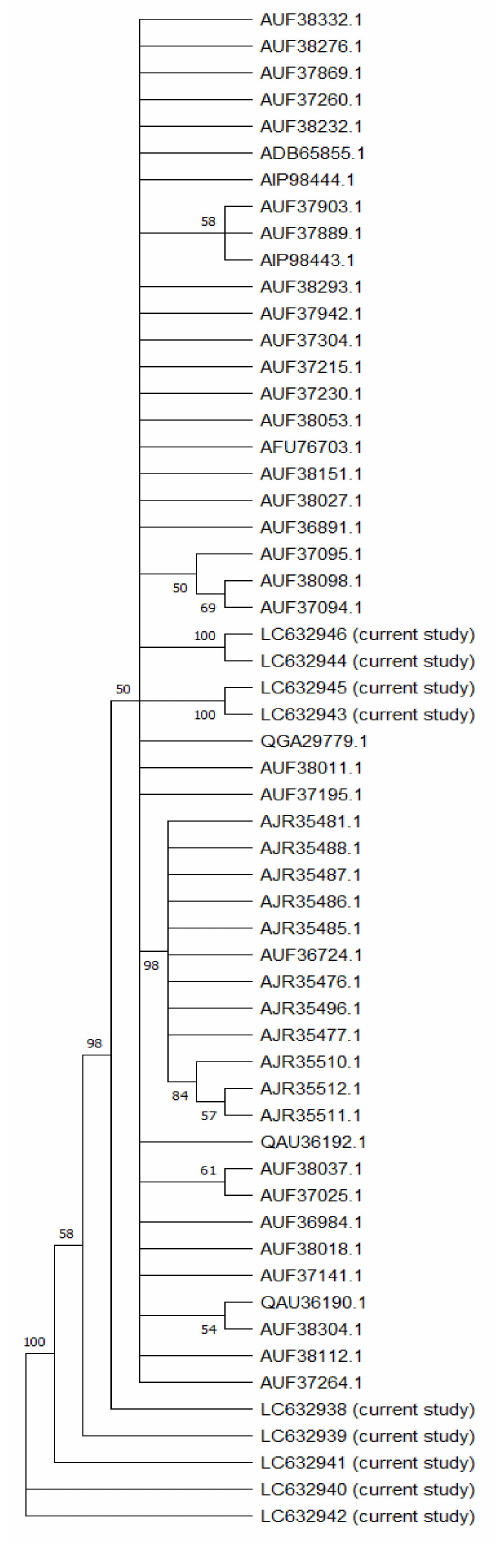
Figure 1. Neighbor-joining phylogenetic tree of the full-length sequence of NS5B of several HCV genotype 4 representatives. Bootstrap values based on 1000 replicates are shown next to the branches; bootstrap values of more than 50% only are shown. Sequences are labeled to the right of each branch in the order of GenBank accession number and isolate